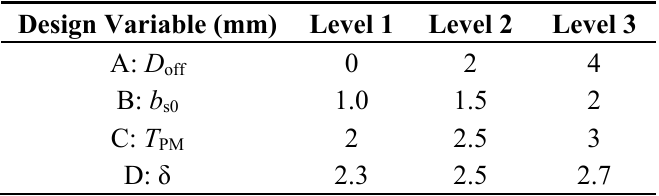
Table 8. Levels of design variables.